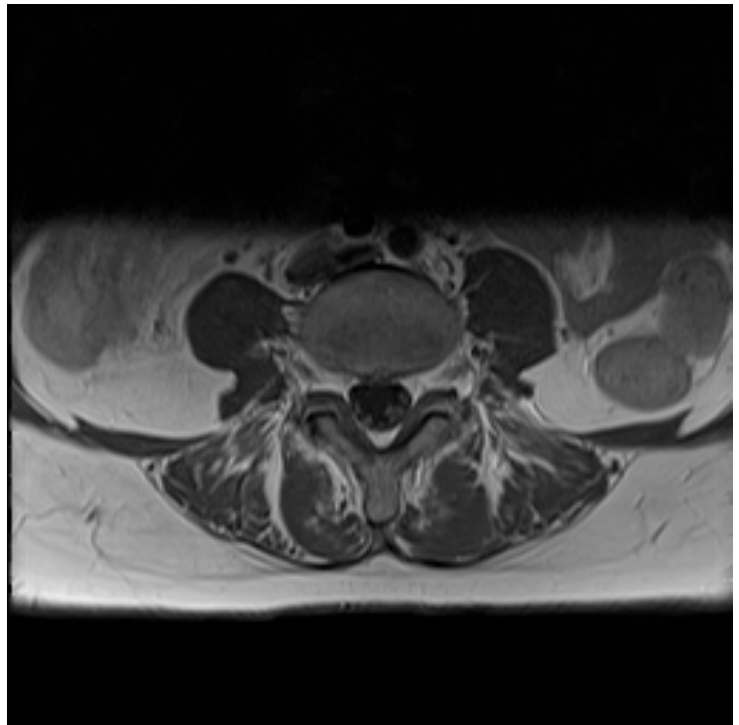
Figure 2. Furthermore, a strong contrast enhancement was shown on MRI of the fibers of the cauda equina and a discrete contrast enhancement of the cervical and thoracic nerve roots. The 18 F-FDG PET / CT was without pathological findings. Intravenous ceftriaxone was initiated upon suspicion of Lyme neuroborreliosis and administered for a total of 14 days. Borrelia burgdorferi (B. burgdorferi) IgG antibodies were elevated in serum, and a positive intrathecal B. burgdorferi IgG antibodies synthesis was detected confirming the diagnosis of Lyme neuroborreliosis. The patient reported to be pain-free after 10 days of antibiotics, and the following month the paralyses almost completely subsided leaving only mild sensory disturbances in the left foot, as sequelae. Lyme borreliosis is a tick-borne infection caused by the B. burgdorferi sensu lato complex. B. burgdorferi can cause a variety of clinical manifestations including skin lesions, Lyme neuroborreliosis, Lyme carditis and Lyme arthritis [1]. The primary and most common manifestation is the skin lesion erythema migrans. Approximately 5– 10% of individuals with an untreated erythema migrans (EM) develop Lyme neuroborreliosis, usually within 2–6 weeks. As illustrated within this case, only 25% and 50% recall a previous tick bite or erythema migrans, respectively, when they present with Lyme neuroborreliosis [2]. With an estimated prevalence of 3-120 per 100,000 inhabitants in Scandinavia, Lyme neuroborreliosis is one of the most prevalent bacterial infections of the nervous system [3,4] . The diagnosis of Lyme neuroborreliosis depends on classical symptoms including radicular pain and paralysis (typically facial paralysis), elevated white blood cells in CSF and the presence of intrathecal B. burgdorferi antibody production. B. Burgdorferi serum serology is not necessarily positive and should be interpreted with caution when suspecting Lyme neuroborreliosis [3] . Though adults with Lyme palsy, symptoms can appear in different stages and be clouded by comorbidities causing potential